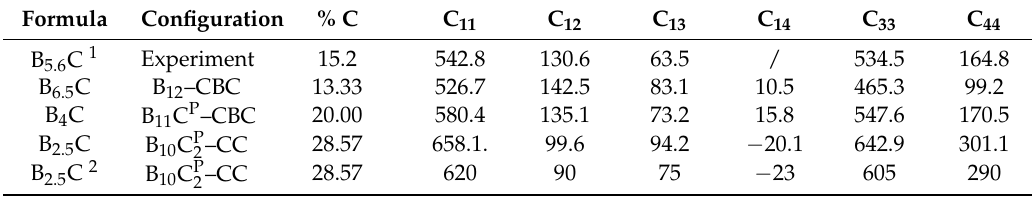
Table 2. The calculated elastic constants Cij (GPa) of boron carbides using the stress-strain method.